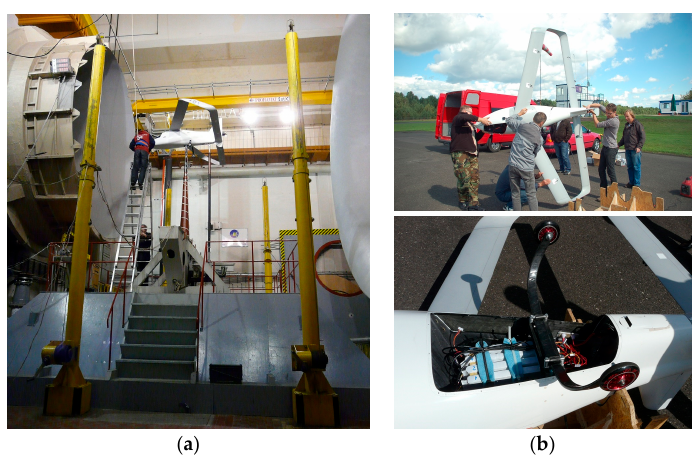
Figure 7. ( a ) Replacement of the batteries in the wind tunnel; and ( b ) replacement of the batteries